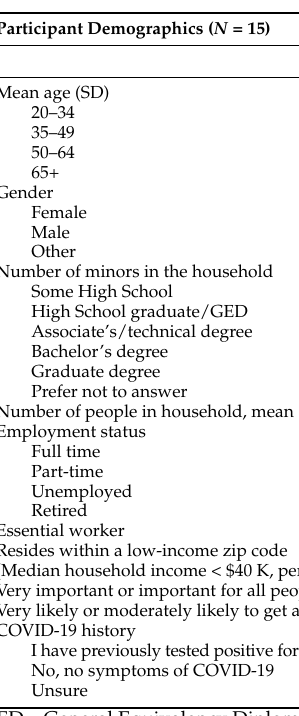
Table 2. Latino Focus Group Participant Demographics.